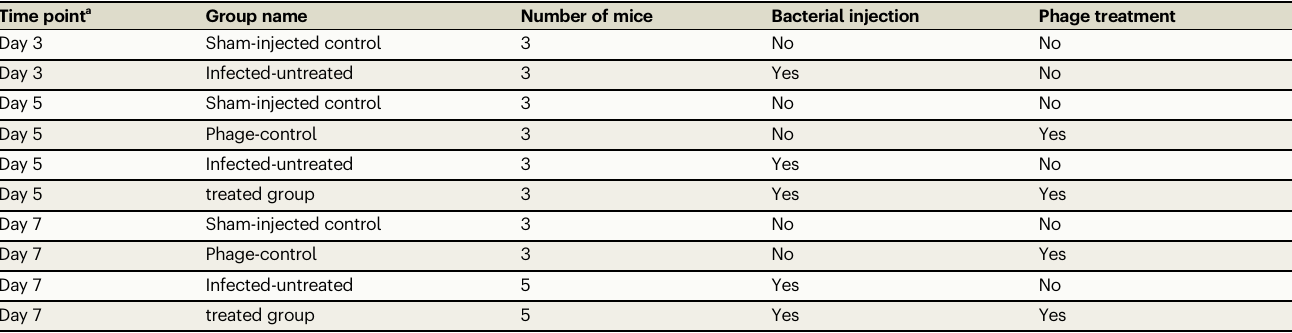
Table 4 | Mice groups in the in-vitro immune response